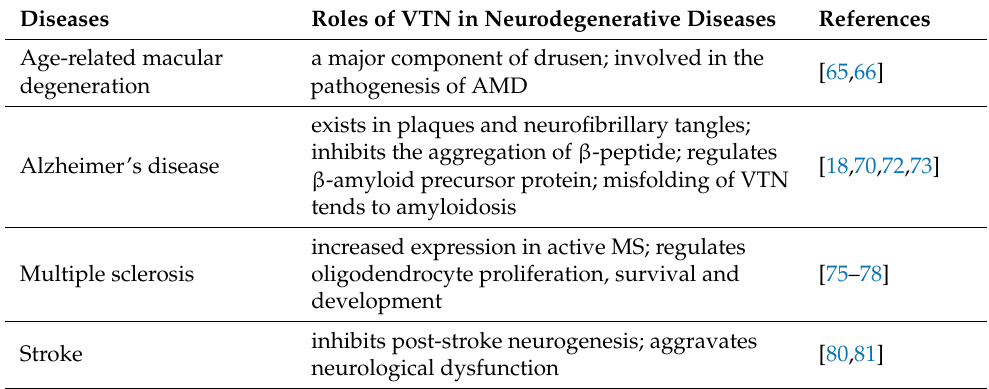
Table 1. Overview of VTN in neurodegenerative